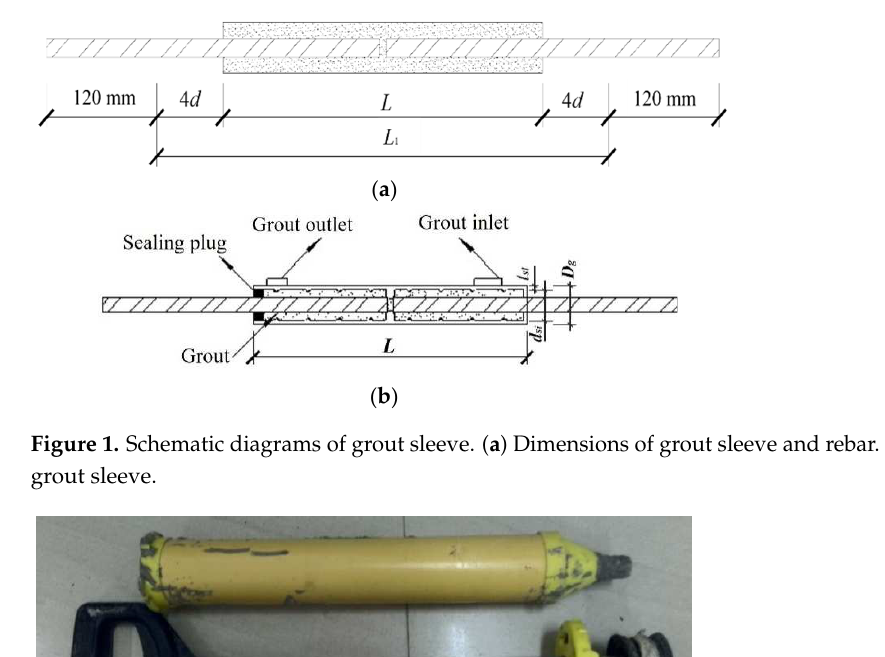
Figure 1. Schematic diagrams of grout sleeve. ( a ) Dimensions of grout sleeve and rebar. ( b ) Details of grout sleeve.